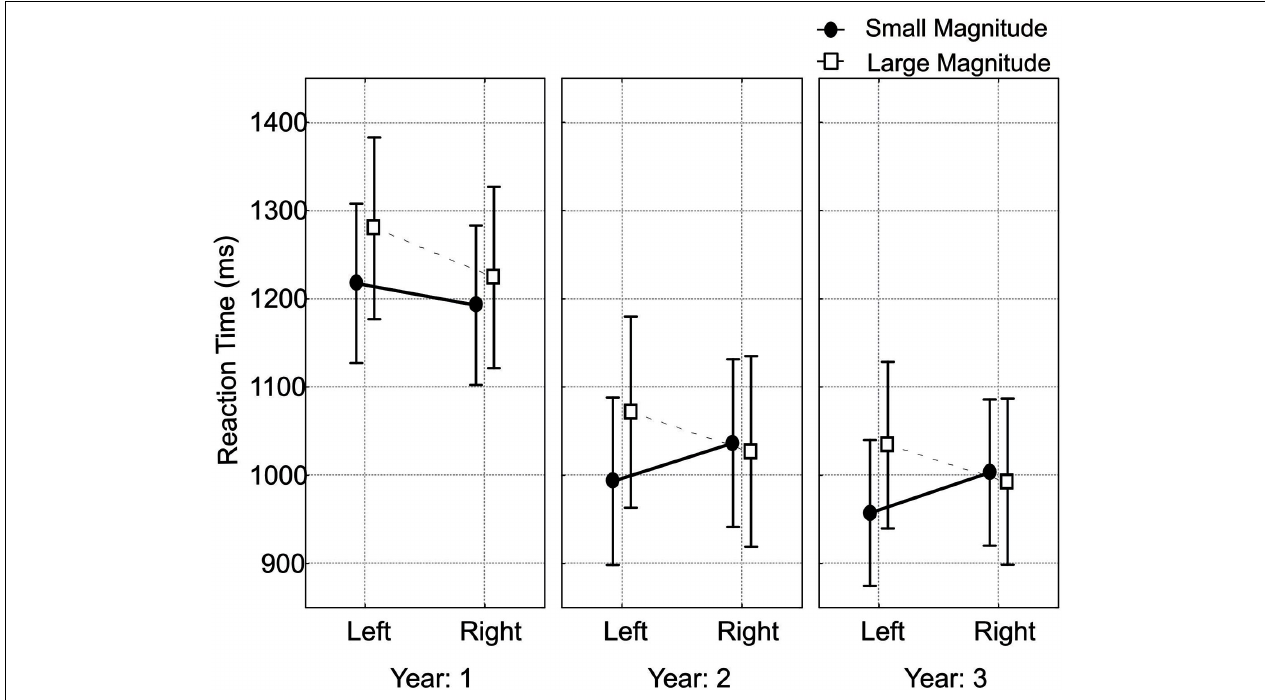
FIGURE 3 |The SNARC effect (Magnitude × Response Side) for RT; the effect was significant inYears 2 and 3. The error bars indicate 95% confidence intervals.